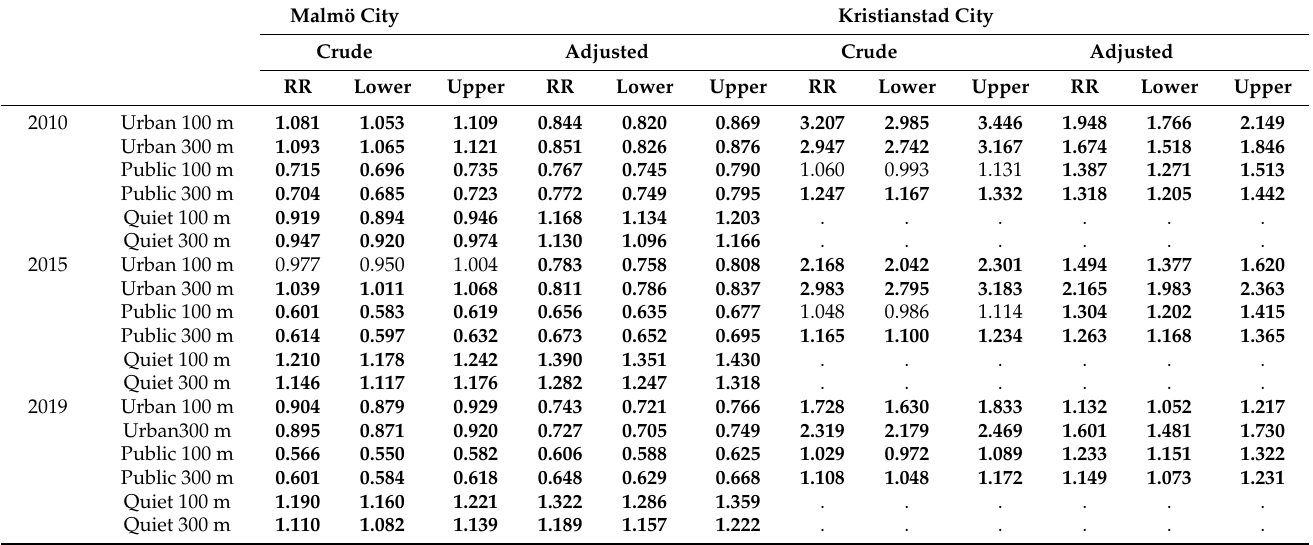
Table A6. Risk ratios for crude and multivariate associations between living in a high SES area vs low SES area in availability to total urban green space (Urban), publicly available urban green space (Public) and quiet publicly available urban green space (Quiet). RR for 100 m and 300 m buffer distances from the residence for the three different types of urban green spaces are presented. Malmö